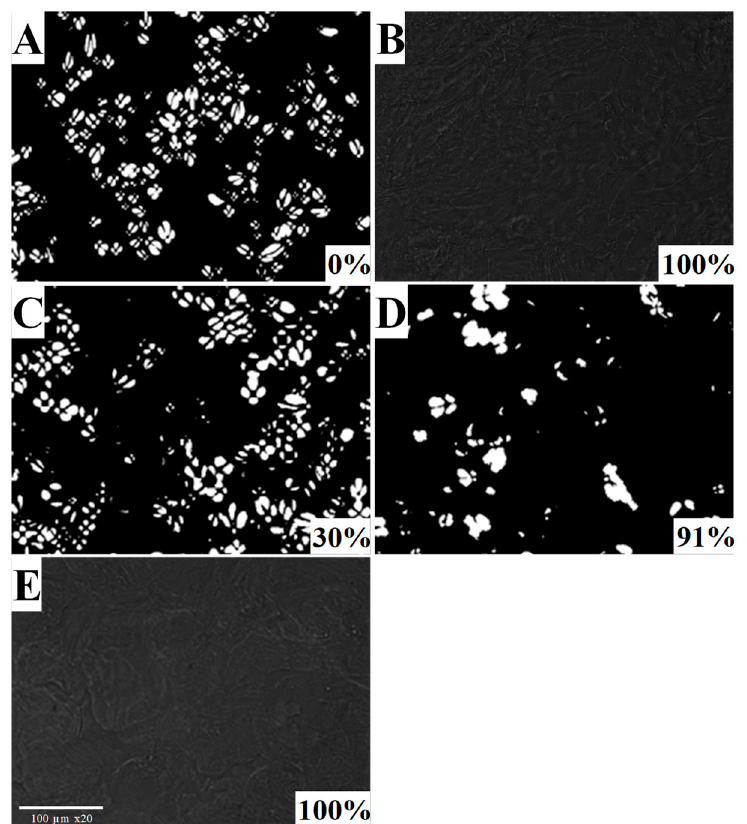
Figure 3. Polarized light micrographs of untreated potato starch suspensions (25 µm, 20% w/w) ( A ), thermal treated ( B ), pressure treated at 600 MPa for 15 min at different processing temperatures, namely 25 °C ( C ), 40 °C ( D ) and 50 °C ( E ), respectively. The % of gelatinization of samples, determined as a function of birefringence loss, are also indicated in the pictures.